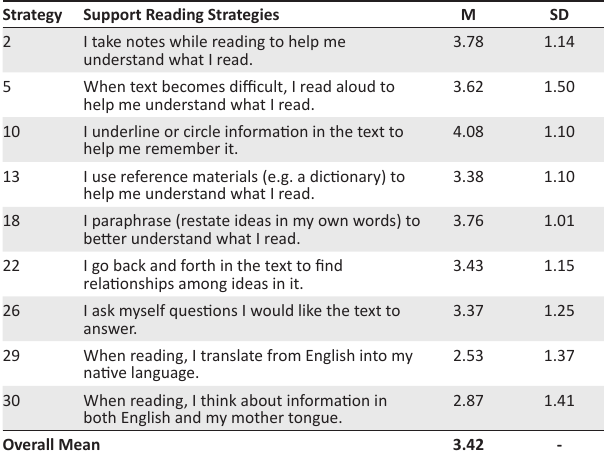
TABLE 3: Support Reading